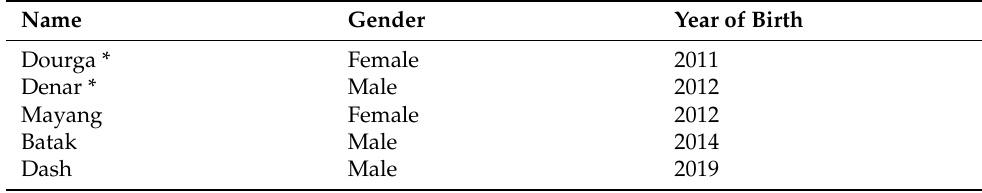
Table 1. Details of the tiger group housed at Fota Wildlife Park during the